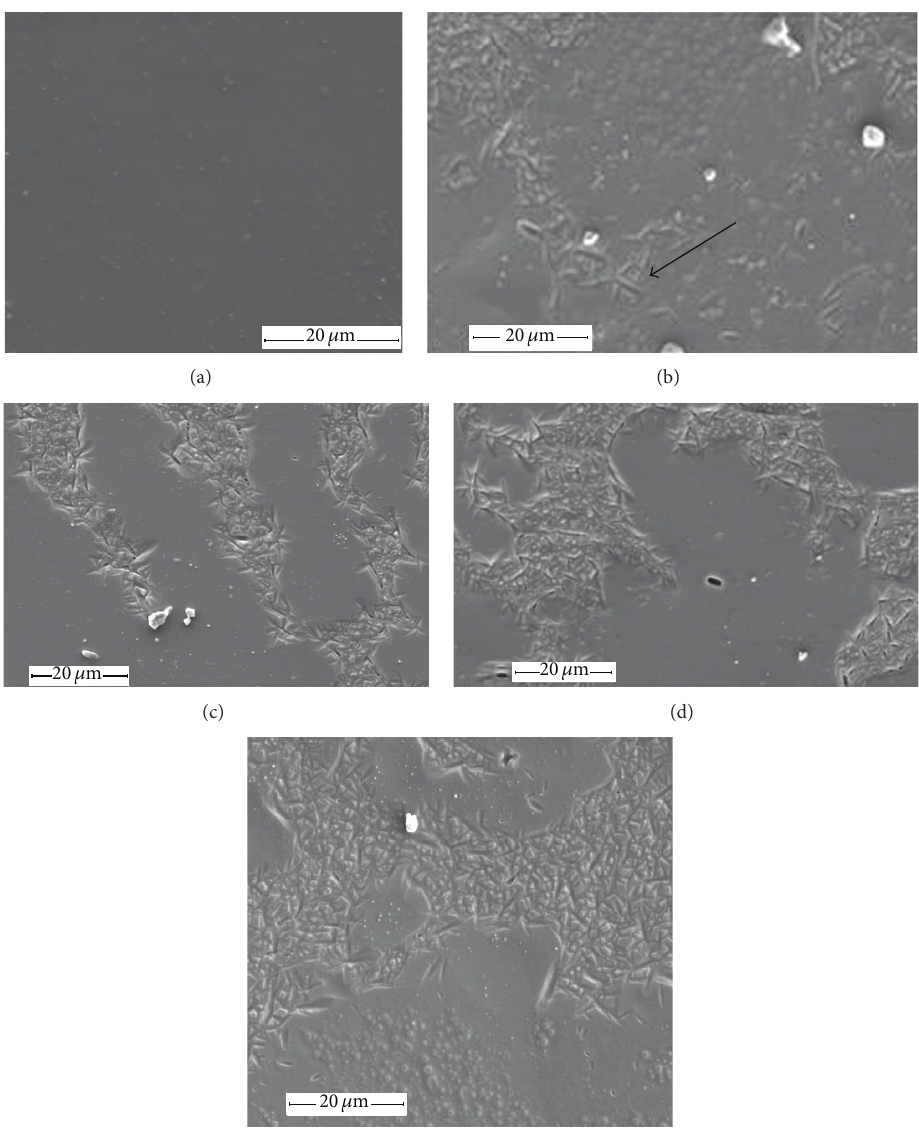
Figure 6: Surface morphology of epoxy exposure by AC electric fields with the following AC electric fields strength: 0V/cm (no treatment) (a); 250 V/cm (b); 500V/cm (c); 750 V/cm (d); 1000V/cm